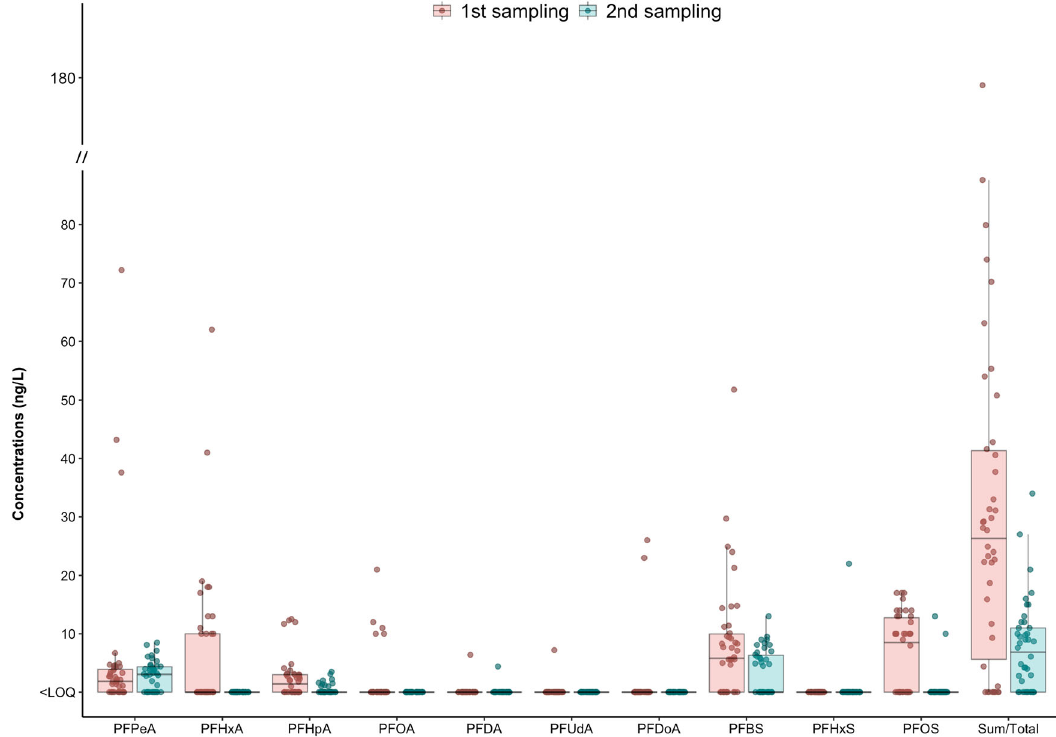
Fig. 1 PFAS concentrations (ng/L) in tap water. Un fi ltered tap water samples were collected in 42 locations in Barcelona, Spain, in repeated sampling campaigns (August – October 2020, and May 2021). The line within the box marks the median, the boundaries of the box indicate the 25th to the 75th percentiles, and the dots denote observations (samples) corresponding to PFAS